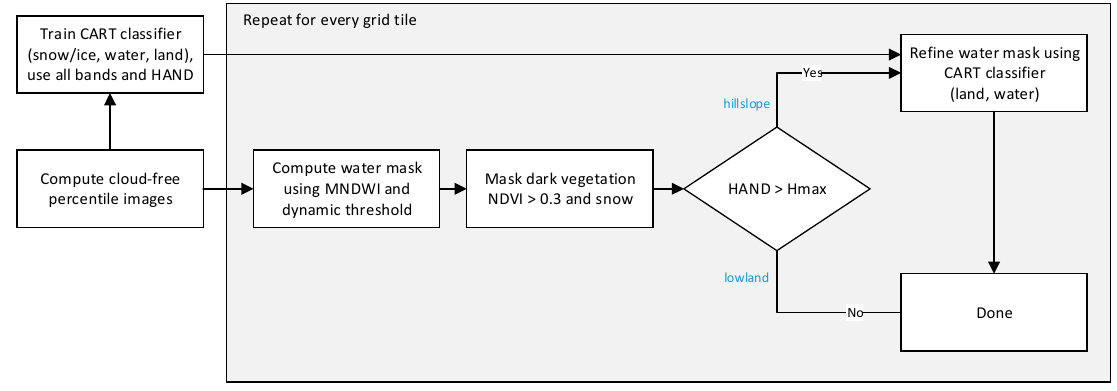
Figure 4. Water detection processing pipeline.